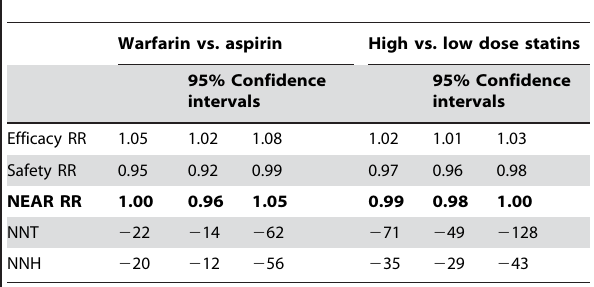
Graphic representation of OR may be seen in Figure 1.